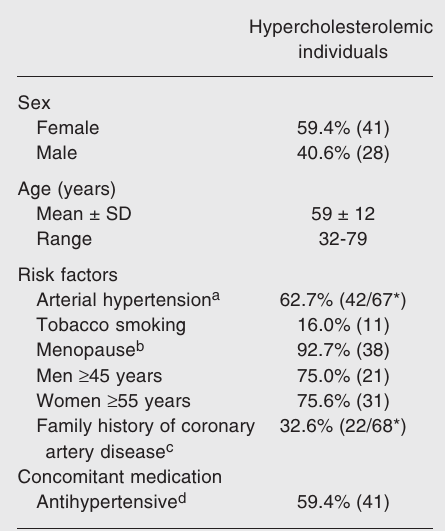
Table 1. Characteristics of Brazilian hypercholes- terolemic individuals of European